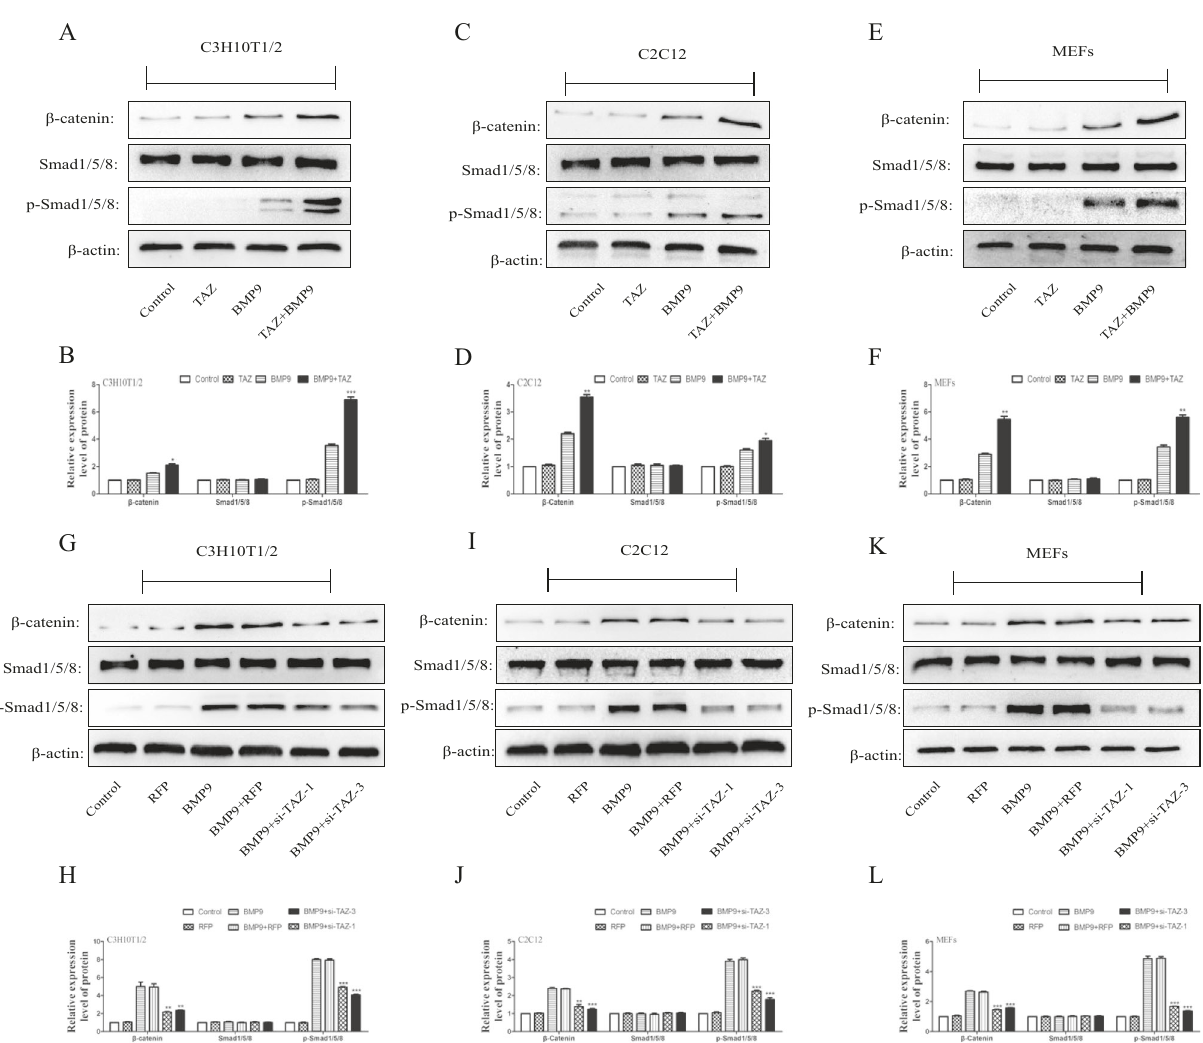
Fig. 5 The effect of TAZ on BMP9-induced classical Smad1/5/8 and Wnt/ β -catenin in MSCs and MMCs. Cells were treated with TAZ or si- TAZ, followed by treatment with BMP9. A – L The total amount and phosphorylated forms of Smad1/5/8 were measured by western blot. A – L The total amount of β -catenin was measured by western blot. The data were shown as mean ± SD for three separated experiments. ( *P < 0.05 , **P < 0.01 , ***P <